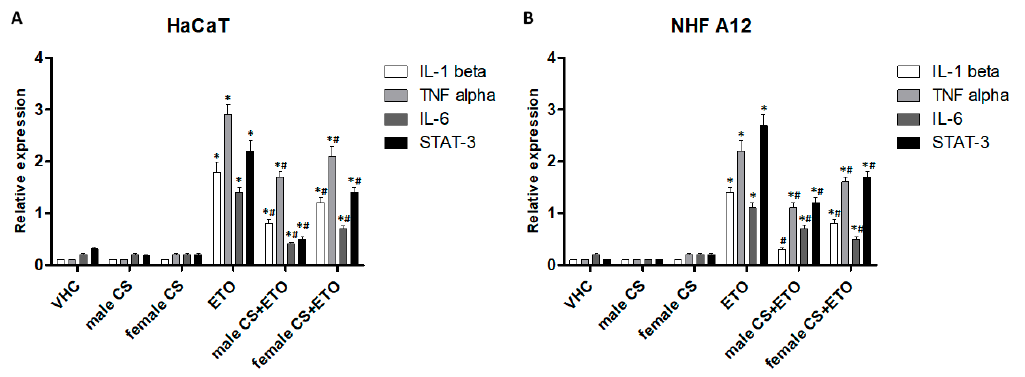
Figure 6. Transcriptional modulation of cytokines genes in HaCaT ( A ) and NHF A12 ( B ) cell lines. Cell lines treated with hemp EOs from female and male inflorescences of cv CS (0.65 mg mL − 1 ) alone or in combination with ETO (0.01 mM). Gene expression was represented as relative expression compared to GAPDH. * p < 0.05 vs vehicle, # p < 0.05 vs ETO.